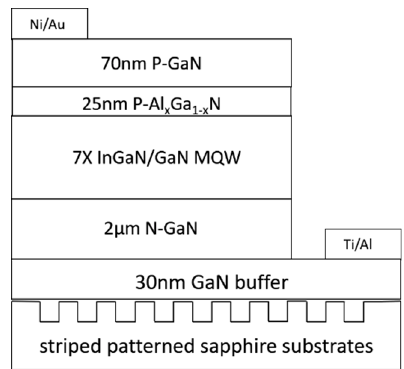
Figure 1. The schematic diagram of GaN-based LED on striped PSS. GaN (gallium nitride),